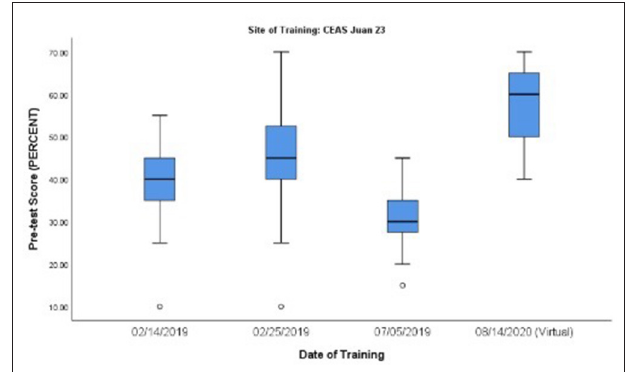
FIGURE 3 | Mean PE&E pre-test scores over time at the CEAS Juan XXIII Hospital